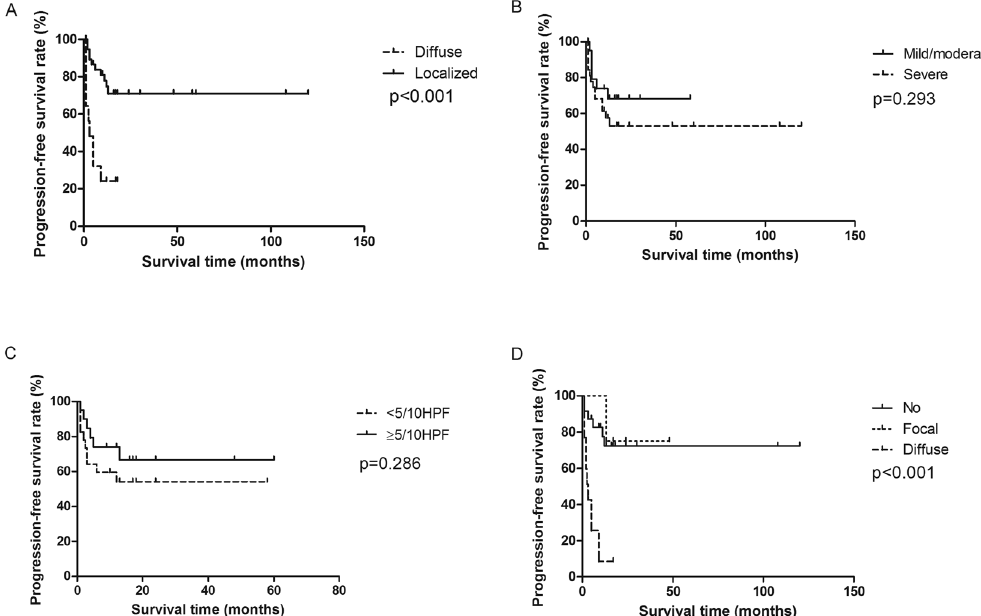
Figure 6. Patients with diffused stage had median PFS of 3 months, in contrast, patients with localized stage had not reached median PFS ( A ). Nuclear abnormalities and mitosis were not associated with PFS ( B , C ). Median PFS of diffuse necrosis was 3 months but patients with no necrosis or localized necrosis had not observed median PFS, with a significant difference ( D ).